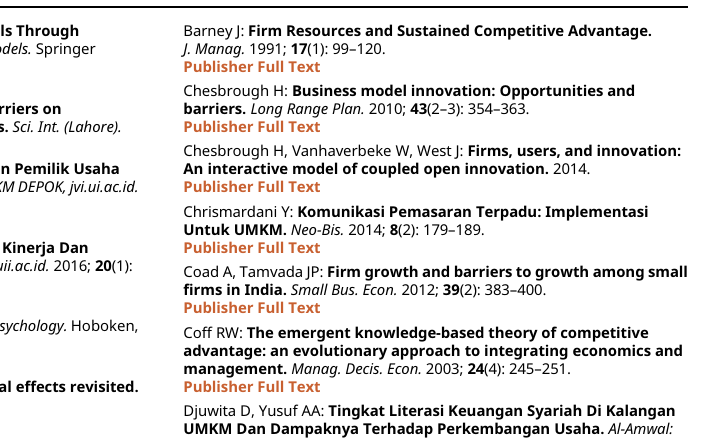
Figshare: Dataset of Questionnaire Result from the roles of self efficacy and sharia financial literacy to SMEs performance: business model as intermediate variable. https://doi.org/10.6084/m9.figshare.17082419 (Srisusilawati,